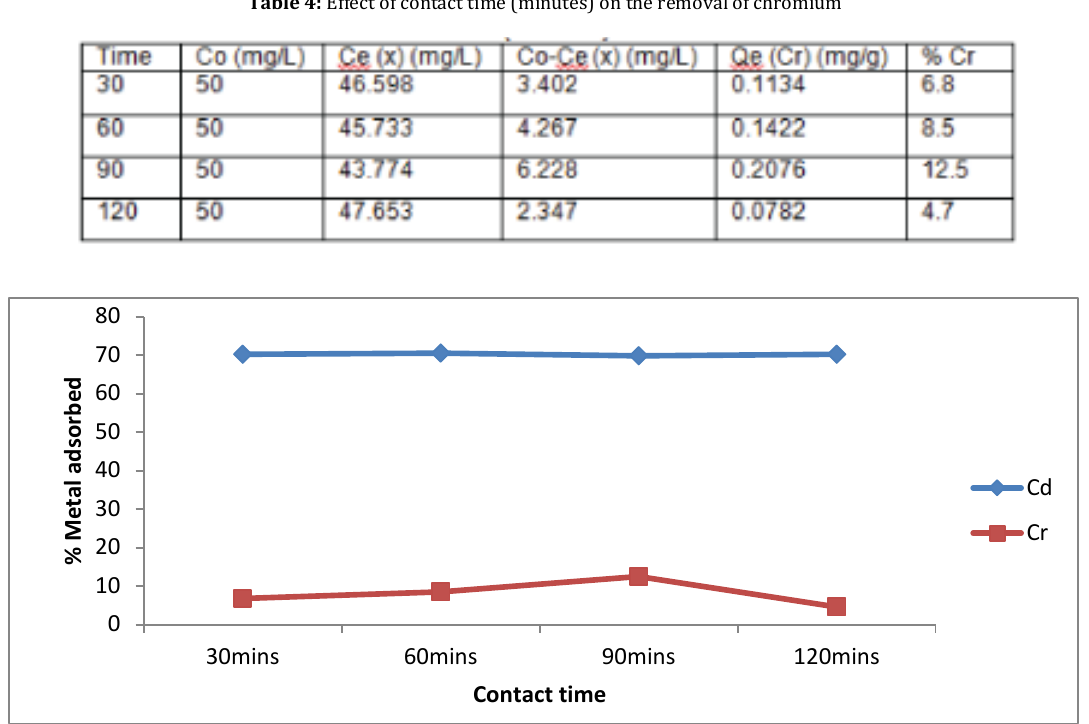
Figure 3: Effect of contact time on the removal of Cd(II) and Cr(VI) from aqueous